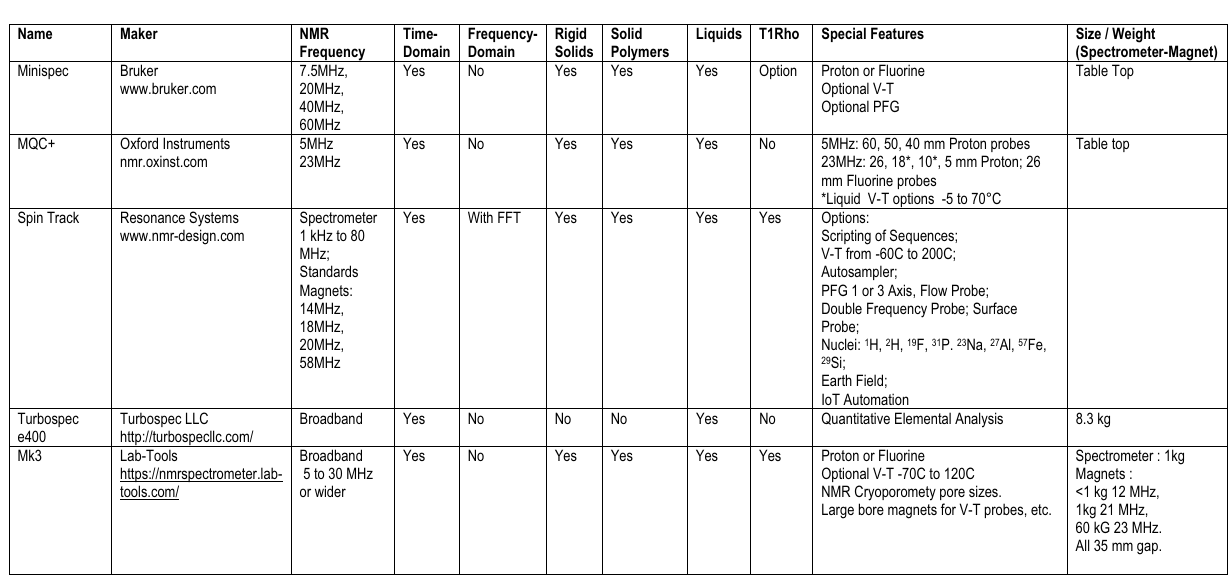
Fig. 5 Benchtop/portable time-domain NMR